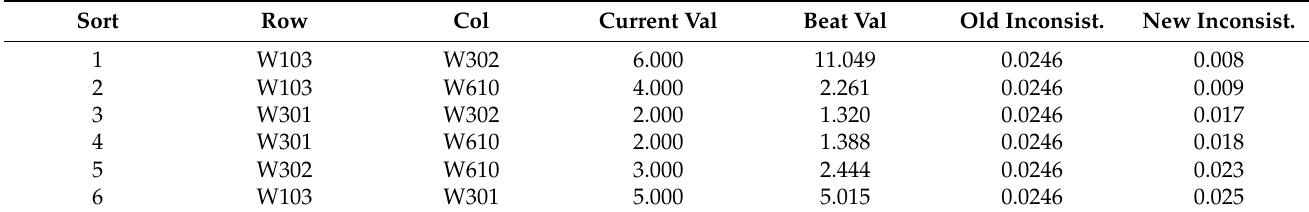
Table 6. Inconsistency report of W101.